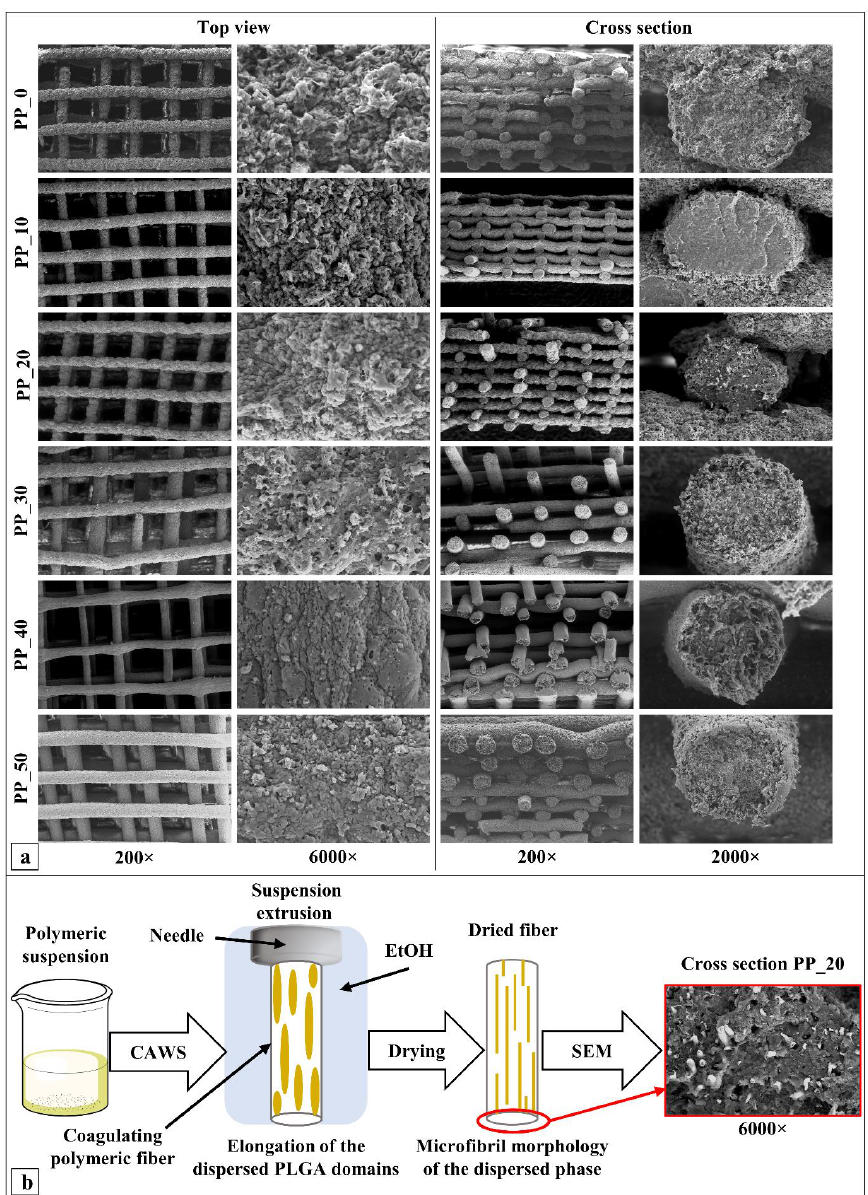
Figure 3. ( a ) Representative top-view ( left ) and cross-section ( right ) SEM micrographs of the fabri- cated scaffolds with different compositions, taken at different magnifications to highlight the 3D layered porous structure of scaffolds (200×), fiber external surface roughness (6000×), and mi- croporous/microfibrillated morphology of the fiber transversal cross-section (2000×); ( b ) schematic representation of the proposed mechanism for two-phase polymeric matrix formation showing the deformation of the dispersed PLGA solution phase during extrusion, leading to the formation of longitudinally oriented microfibrils dispersed in a continuous polymeric phase, as observed in the included SEM micrograph (6000 ×